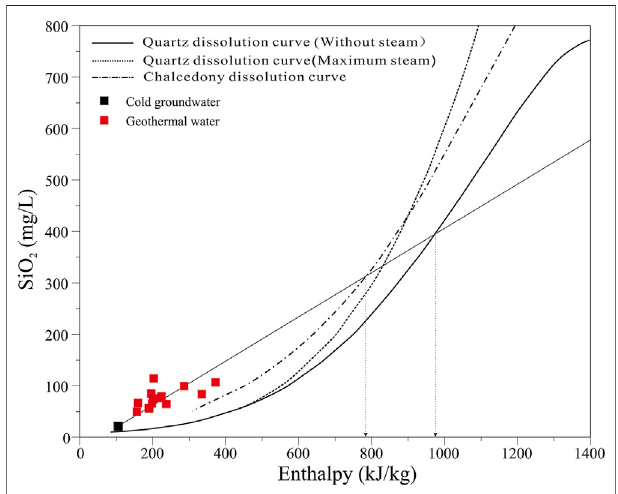
FIGURE 8 | Silica-enthalpy illustration method.